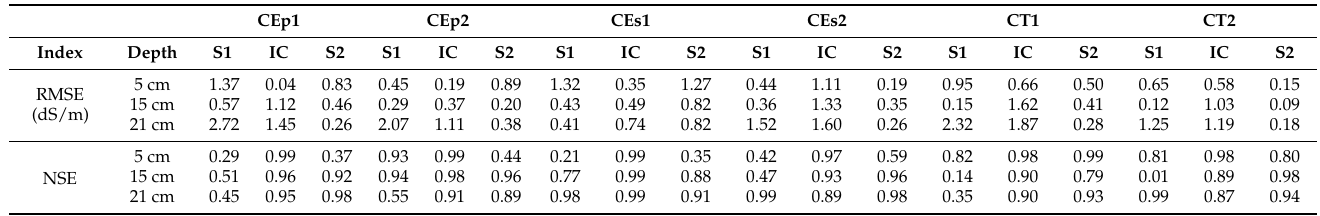
Figure 3. Dynamics of electrical conductivity (ECw) measured in soil solution (M) and simulated with Hydrus-1D (S) at 5, 15 and 21 cm soil depths in soil columns for the three treatments during the experiment. S1 is the first cropping season, IC is the intercropping season, S2 is the second cropping season, CEp1 ( a ) and CEp2 ( b ) are the columns cultivated permanently with E. stagnina , CEs1 ( c ) and CEs2 ( d ) are the columns cultivated with seasonal E. stagnina , and CT1 ( e ) and CT2 ( f ) are the columns with bare soil. Table 4. Root mean square error (RMSE) and Nash-Sutcliffe model efficiency coefficient (NSE) calculated between measured results and simulated results for the dynamics of electrical conductivity (ECw) at depths of 5, 15 and 21 cm during the first cropping season (S1), the intercropping season (IC) and the second cropping season (S2) in the six columns. CT1 and CT2 are columns with bare soil, CEs1 and CEs2 are columns cultivated with seasonal E. stagnina and CEp1 and CEp2 are columns cultivated permanently with E. stagnina